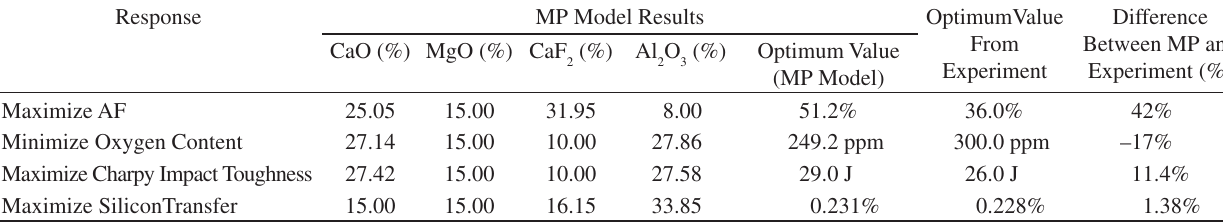
Table 3. Comparison of single objective MP model results with experimental